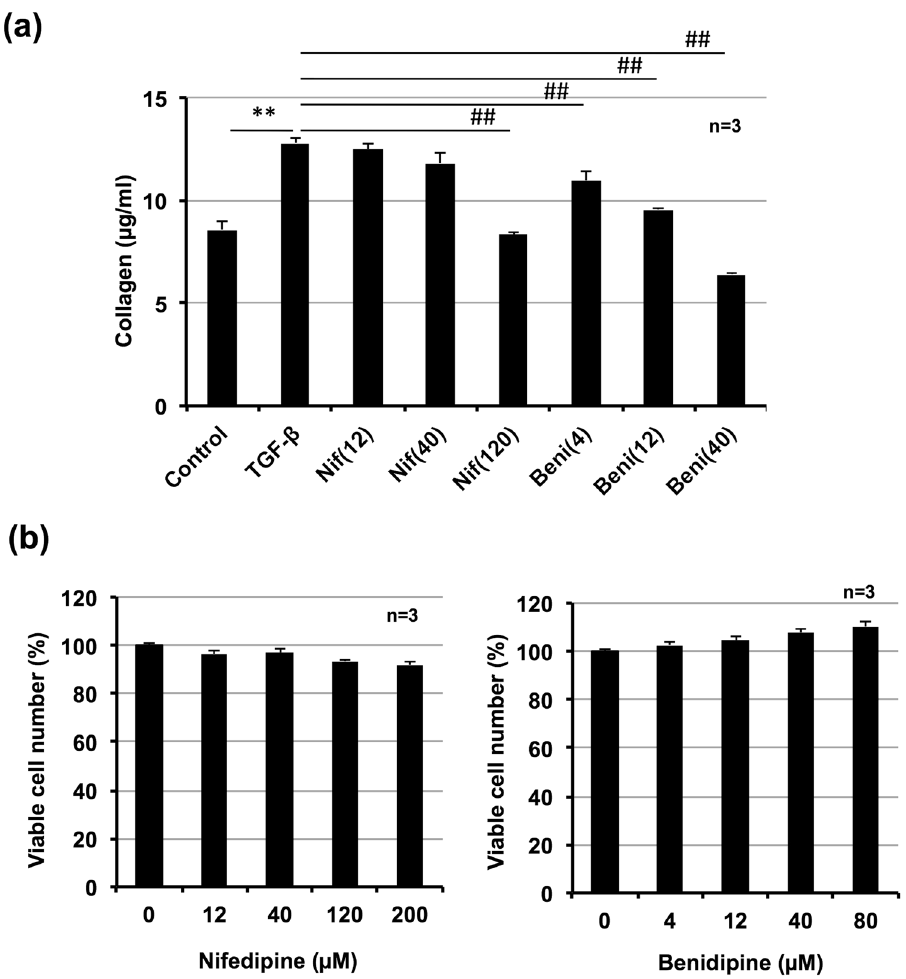
Figure 5. Effect of other calcium channel blockers on TGF- β 1-induced collagen production. LL29 cells were incubated with TGF- β 1 (5 ng/ml) for 48 h ( a ) or 24 h ( b ) in the presence of indicated concentrations ( µ M) of nifedipine (Nif) or benidipine (Beni). Level of collagen in culture medium was determined by Sircol assay ( a ). Viable cell number was determined by MTT method ( b ). Values represent mean ± S.E.M. * * or ## P < 0 . 01 . ( * vs Control, # vs TGF- β